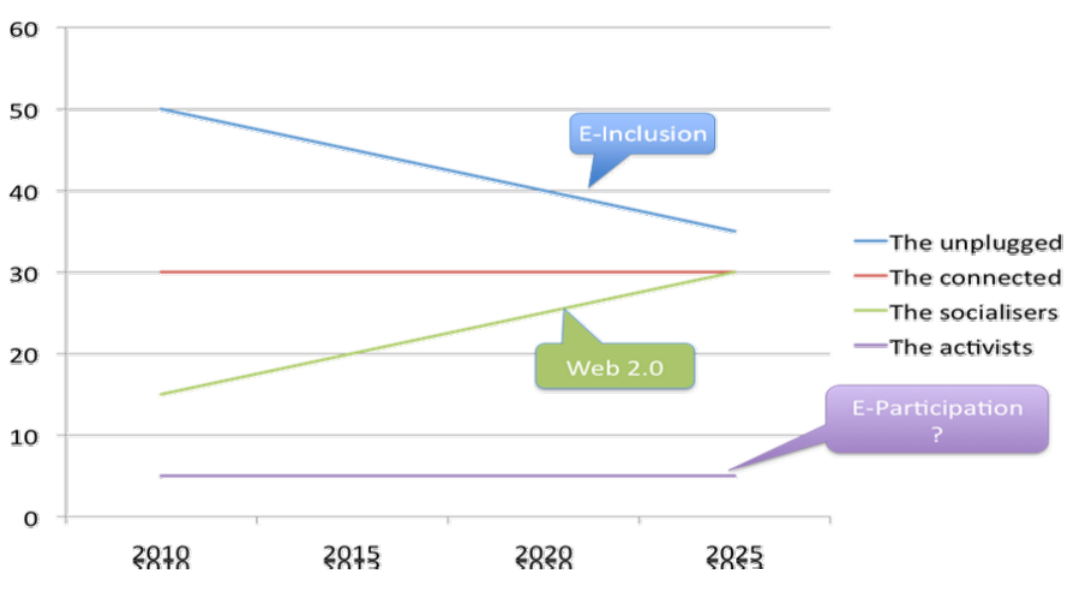
Figure 3: Expected time evolution of the ASCU communities